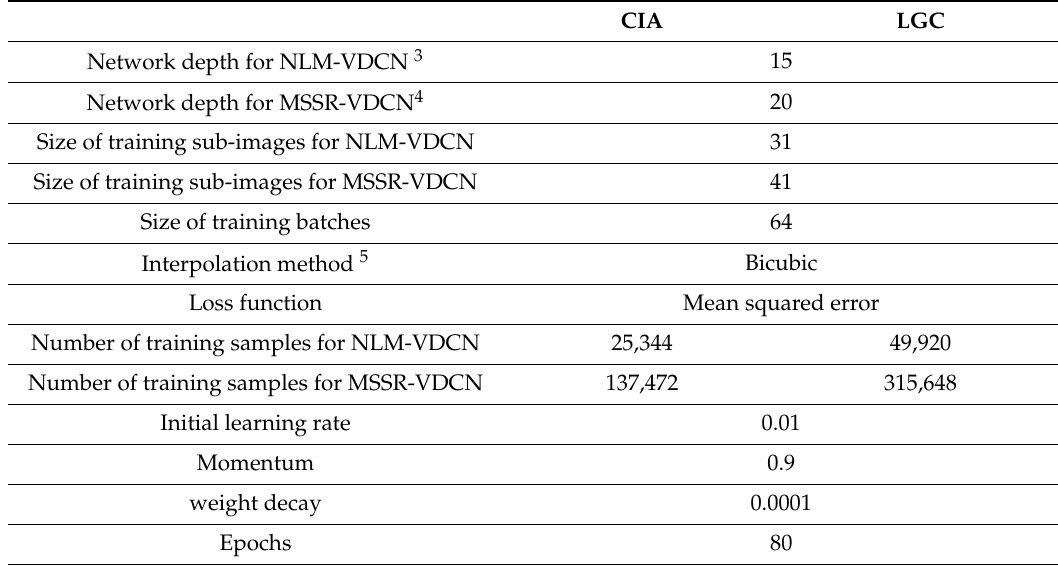
Table 1. Parameter settings of VDCNSTF for CIA 1 and LGC 2